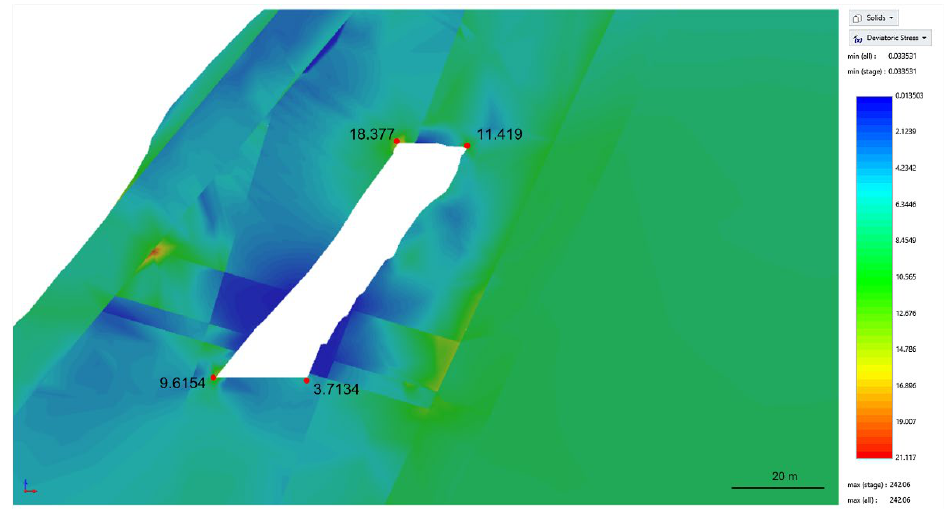
Figure 20. Deviatoric stress ( σ 1 – σ 3 ) of Section S1 calculated in MPa; the model includes the representation of future excavation.